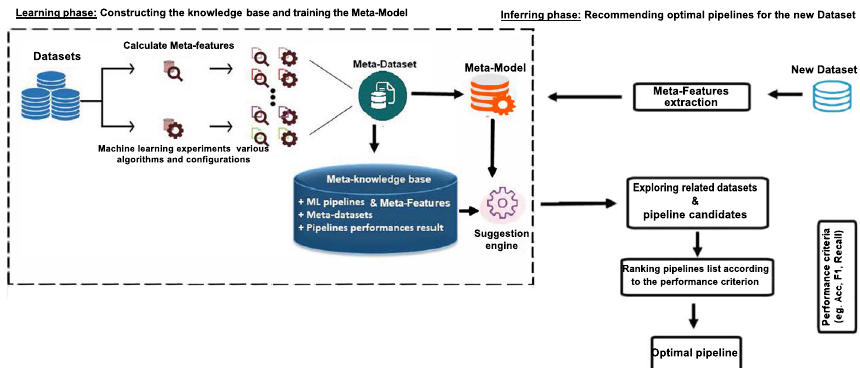
Fig. 1 The workflow of the meta-learning